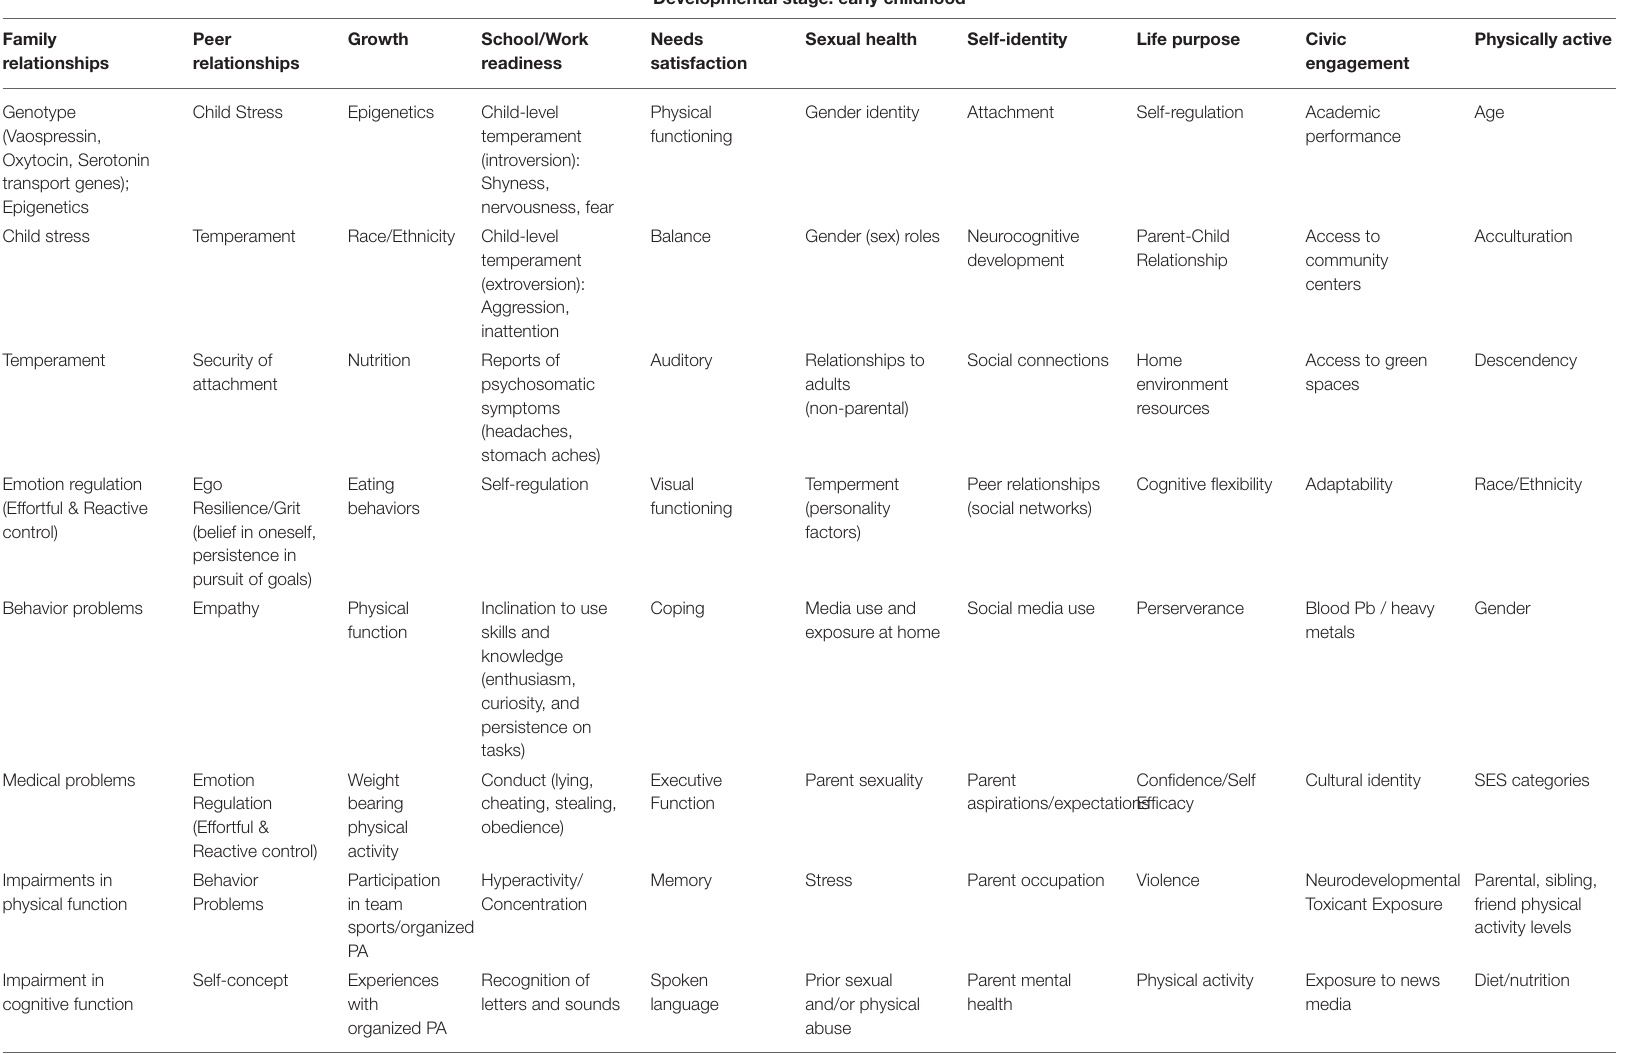
Developmental stage: early childhood